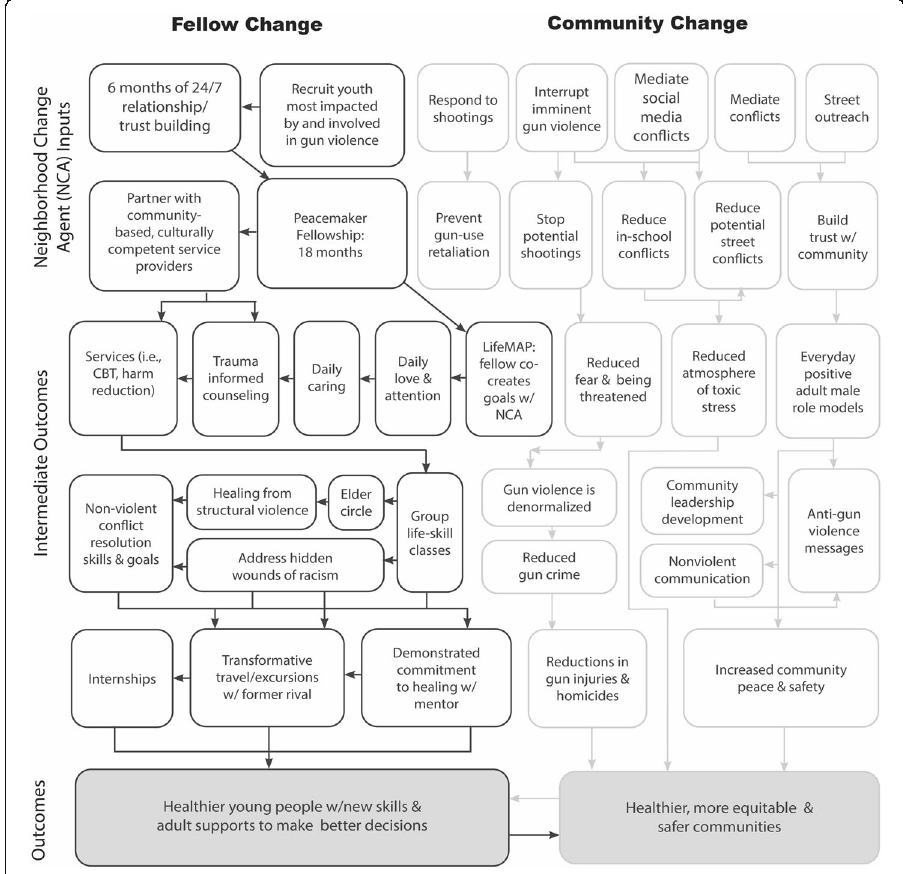
Fig. 1 The Advance Peace Model of Healing & Urban Gun Violence